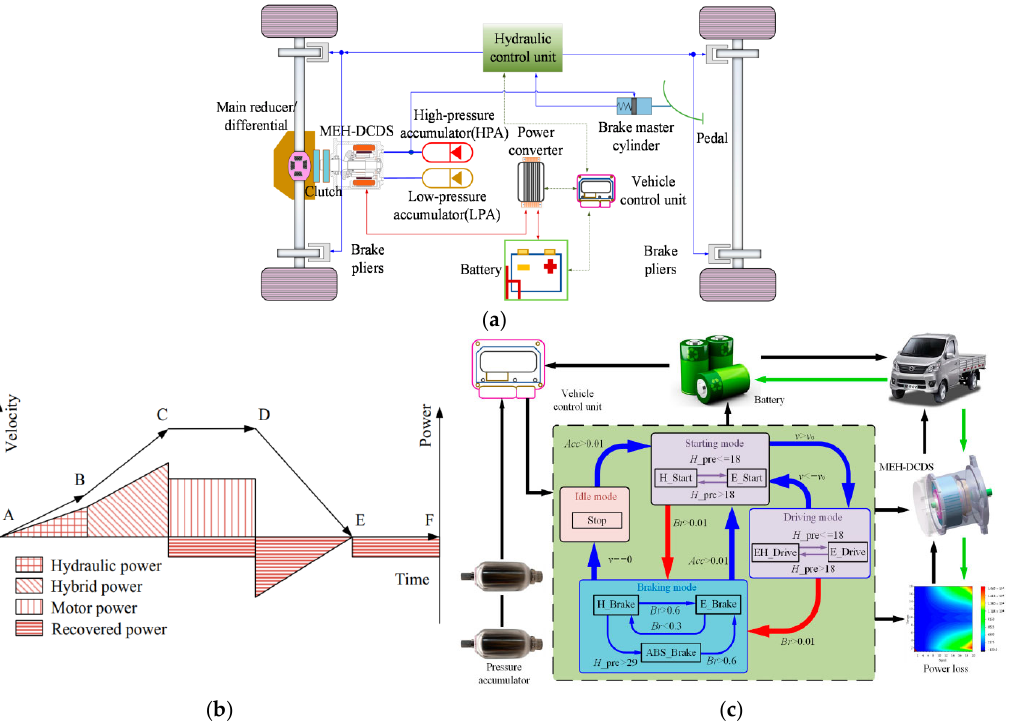
Figure 15. Configuration, working modes and control scheme of proposed MEH ‐ DCDS [97] : ( a ) di ‐ agram of the structure; ( b ) working mode diagram; ( c ) energy management strategies.